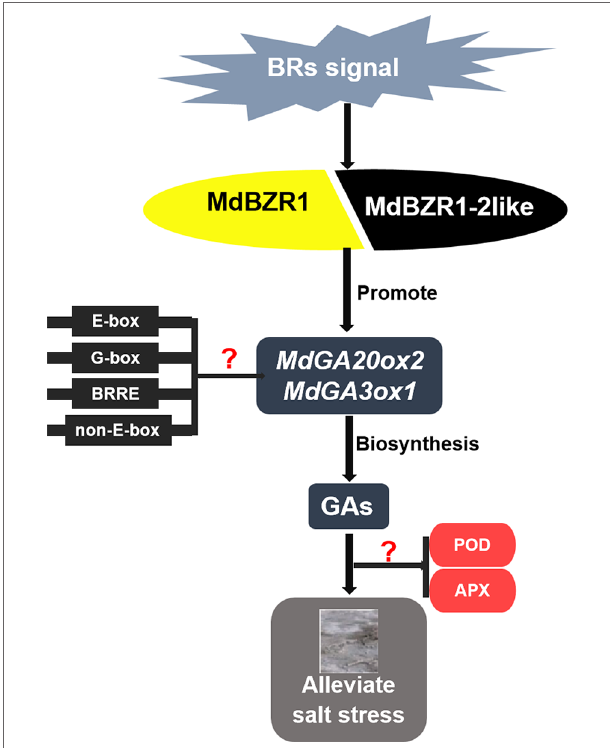
FIGURe 7 | Proposed model for the mechanism of MdBZR1 and MdBZR1- 2like in regulating gibberellin biosynthesis to improve salt tolerance. Question marks indicate sections lacking experimental